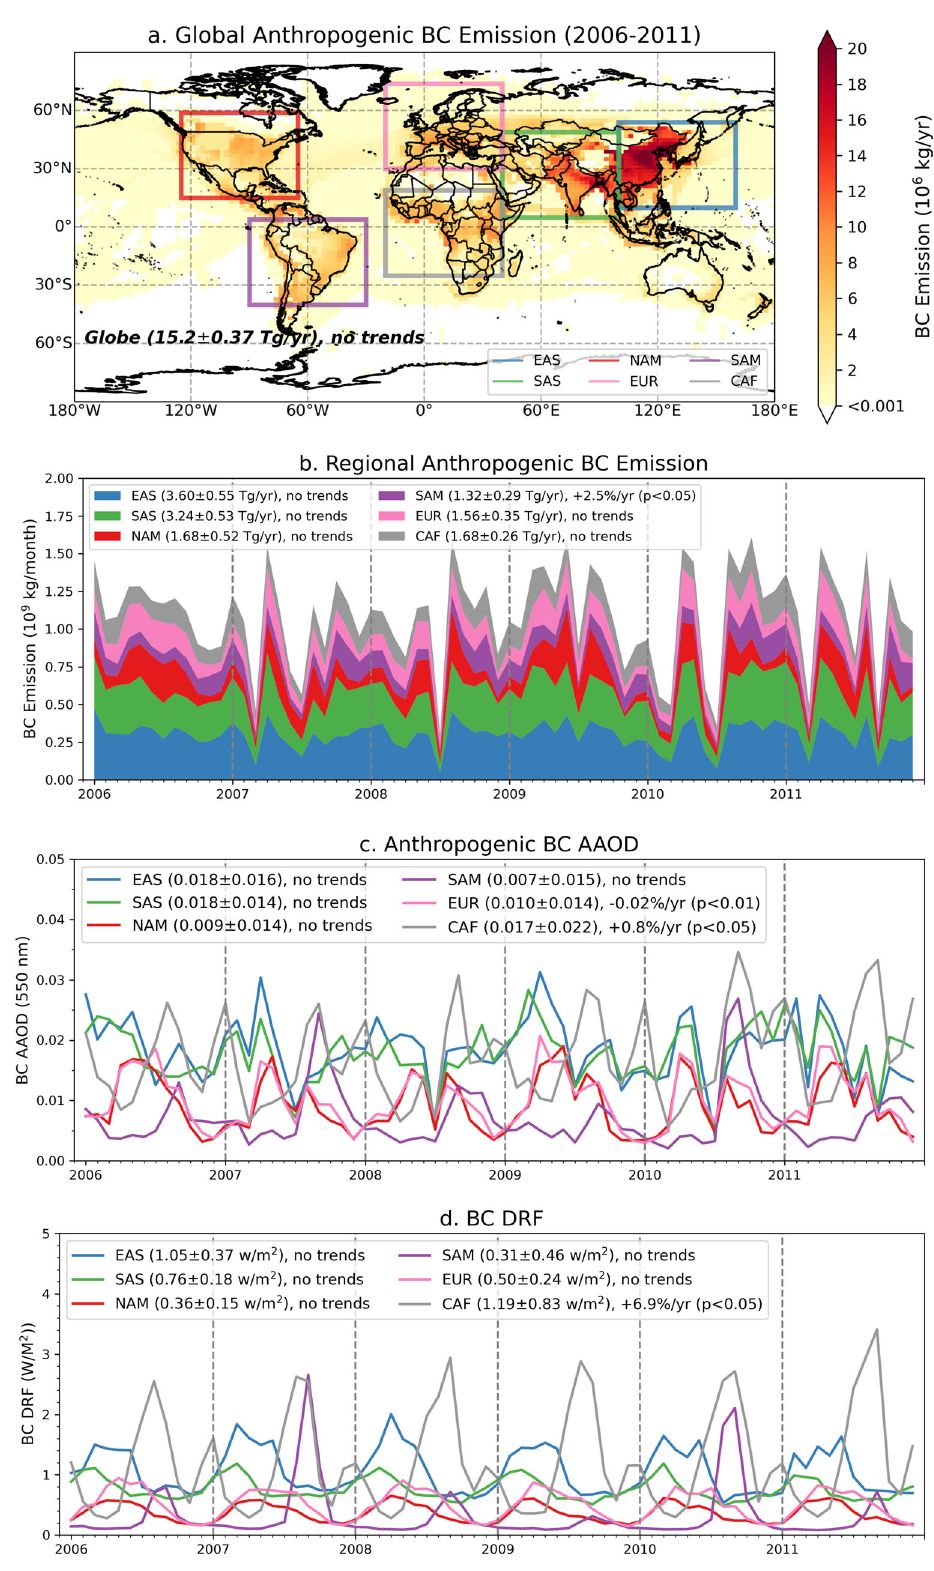
Fig. 4 | Regional variations in monthly anthropogenic black carbon (BC) emissionsanditsopticalandclimateeffectsfrom2006to2011over6selected regions:EastAsia(ESA),SouthAsia(SAS),NorthAmerica(NAM),Europe(EUR), South America (SAM) and Central Africa (CAF). a Global spatial distribution of annualmeananthropogenicBCemissionfrom2006to2011. b Regionalvariationof